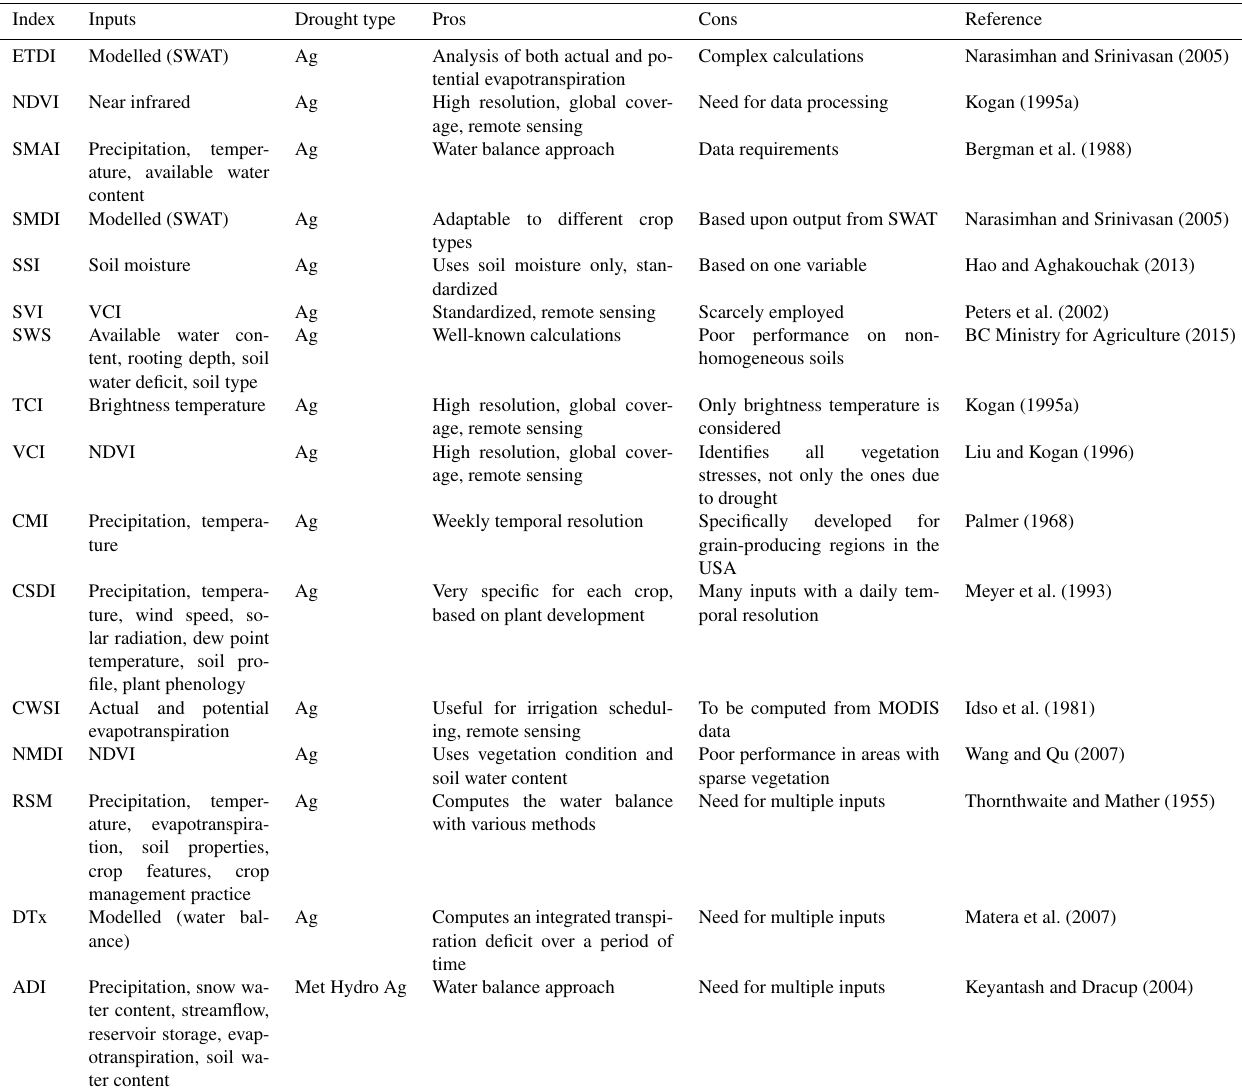
Table 1. An overview of indices used in agricultural drought monitoring; Met is meteorological, Hydro is hydrological, Ag is